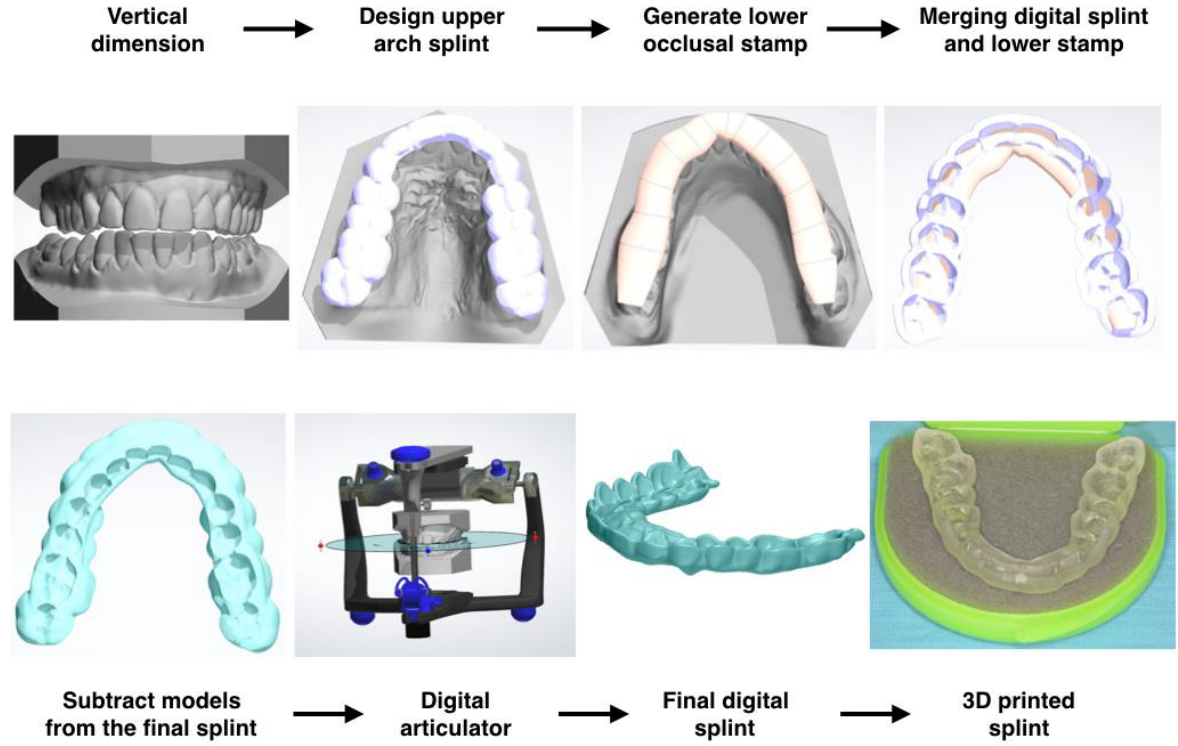
Figure 16. Example of digital workflow for the production of an occlusal splint using Appliance Design software (3Shape, Copenhagen, Denmark).